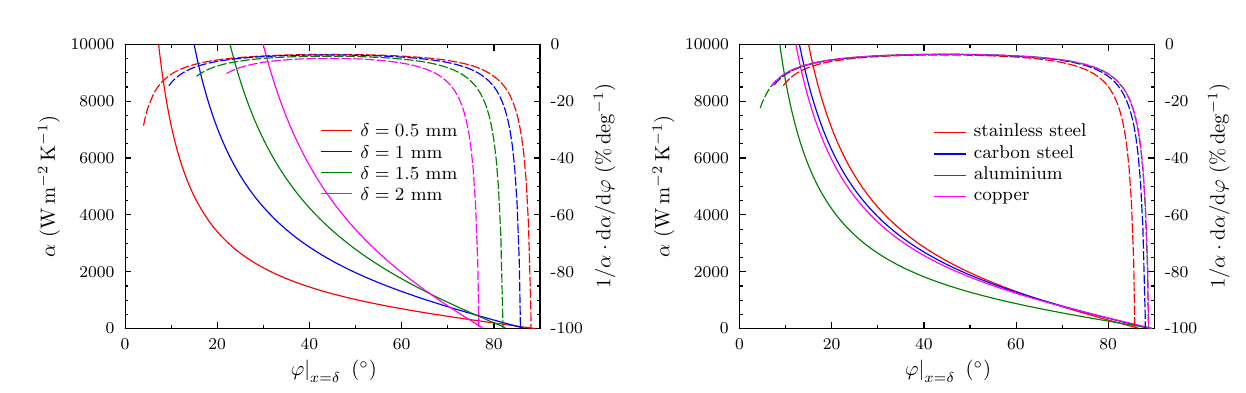
Fig. 2. The dependency of heat transfer coe ffi cient α on phase shift ϕ | for di ff erent wall widths (left) and for di ff erent materials x = δ (right). The dotted lines represent the relative sensitivity of the heat transfer coe ffi cient with respect to the phase shift, which is the derivative 1 /α · d α/ d ϕ (see the right axis). The dependency is illustrated for 0 . 1 Hz frequency of the oscillating heat flux. The wall material is stainless steel, see properties in Table 1. The heat transfer on the irradiated side is 3 Wm − 2 K − 1